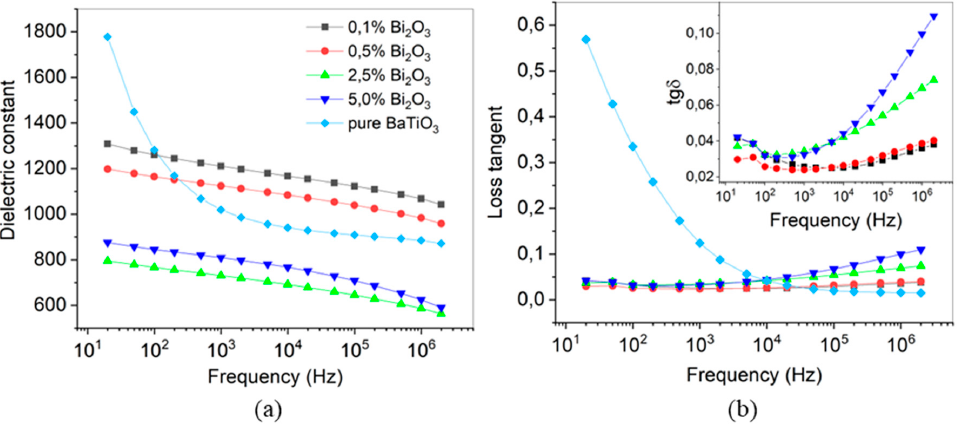
Figure 8. Dielectric constant ( a ) and loss tangent ( b ) vs. frequency for BaTiO 3 ceramics sintered at 1225 °C with different contents of Bi 2 O 3 .